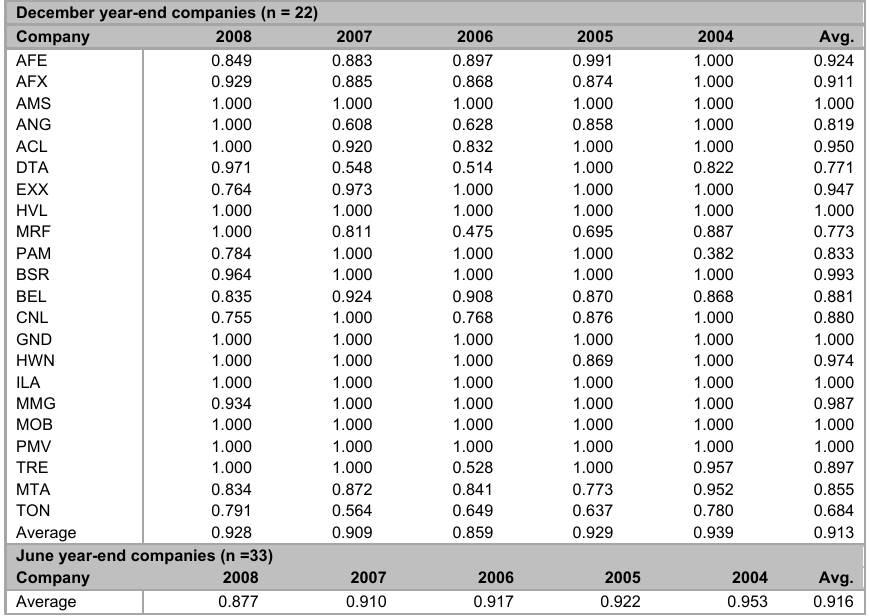
Input-orientated technical efficiency of companies, 2004-2008